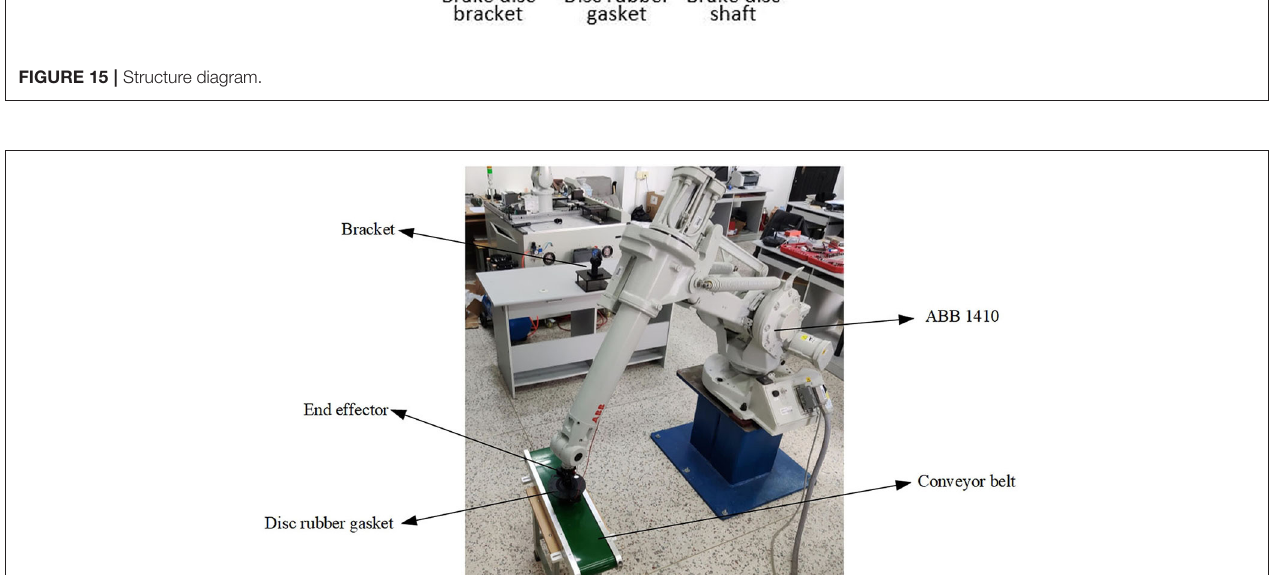
FIGURE 15 | Structure diagram.